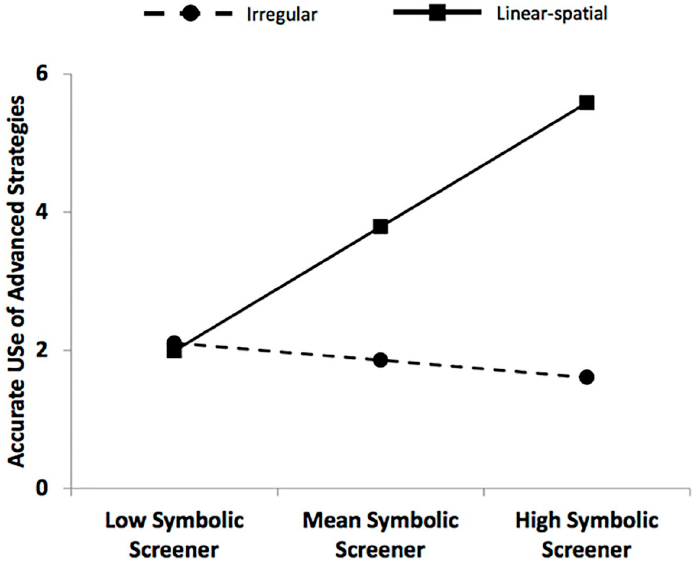
Fig 4. Conditional effect of pretest numerical magnitude knowledge on the number of problems accurately answered via an advanced strategy on the arithmetic assessment at posttest. Predicted accuracy scores were calculated at -1, 0, and 1 SD from the mean on the Numeracy